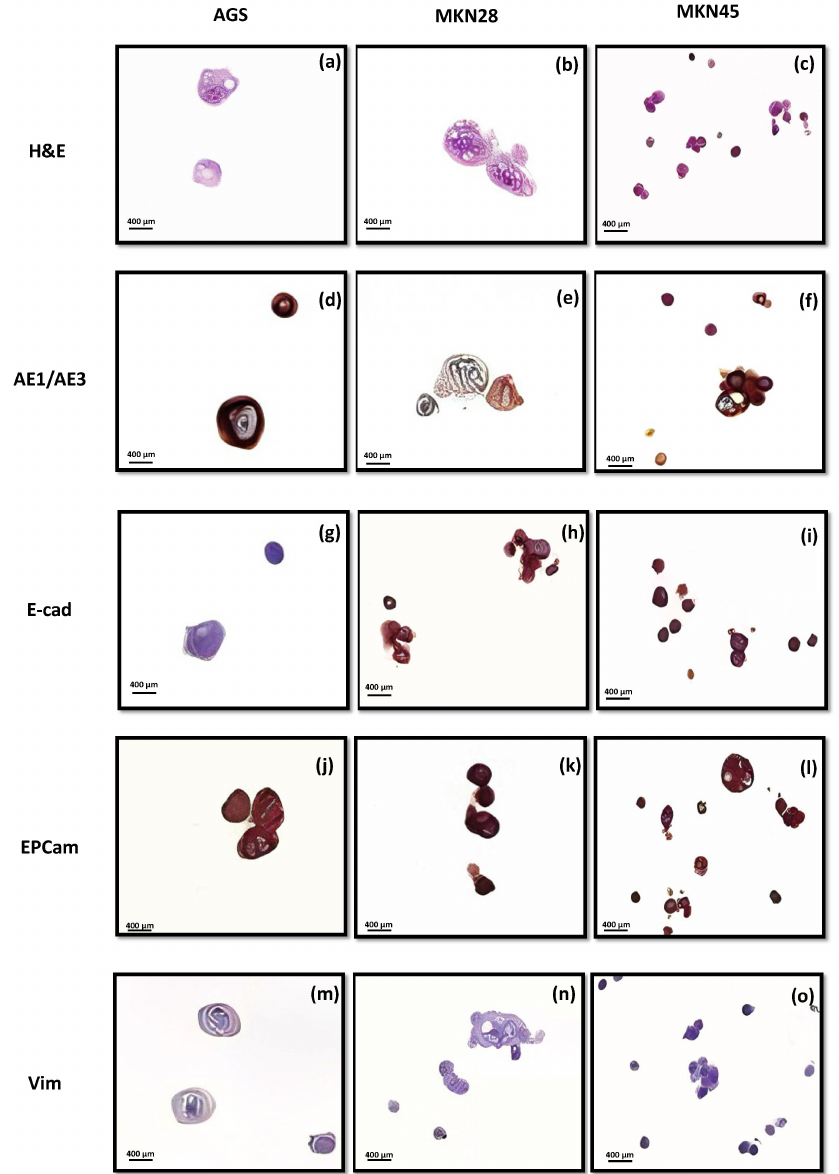
Figure 6. Immunocytochemistry of AGS, MKN28, and MKN45 cell lines: ( a ), ( b ), and ( c ) microscopic examination revealing different characteristics of every cell line (H&E); ( d (+) e and f (+++)) for AE1/AE3; ( g (0), h (+), i (+++)) for E-cadherin; ( j ), ( k ), and ( l ) positive immunoexpression of EPCam (++); ( m , n, and o (0)) for vimentin. Magnification, 40 × ; scale bars, 400 µ